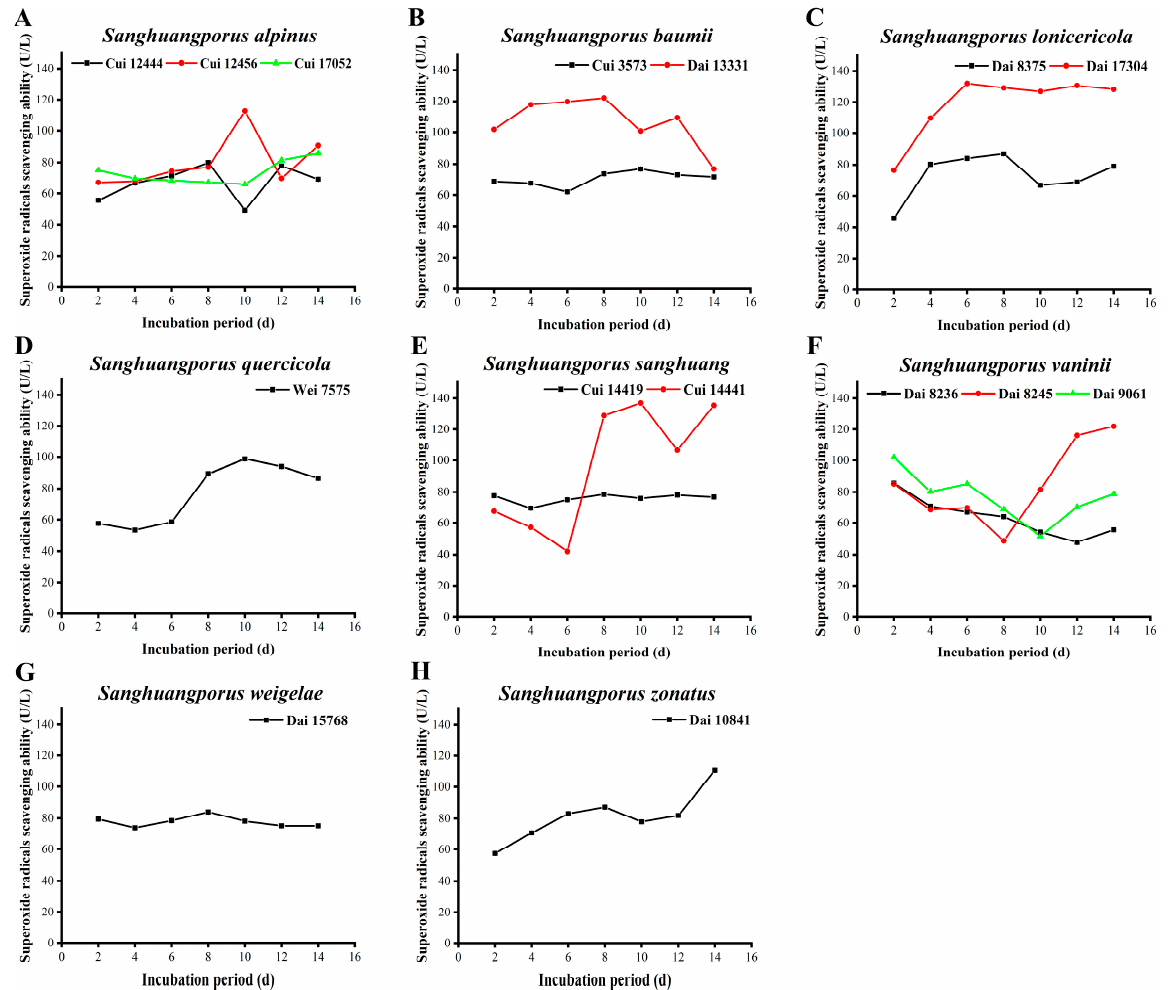
Figure 8. Variations in superoxide radical scavenging activities during submerged fermentation of 15 wild strains from 8 species of Sanghuangporus. ( A ) Sanghuangporus alpinus Cui 12444, Cui 12456, and Cui 17052. ( B ) Sanghuangporus baumii Cui 3573 and Dai 13331. ( C ) Sanghuangporus lonicericola Dai 8375 and Dai 17304. ( D ) Sanghuangporus quercicola Wei 7575. ( E ) Sanghuangporus sanghuang Cui